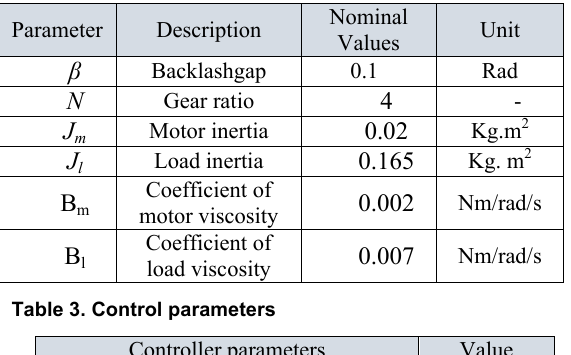
Table 2. Nominal parameters for the two-mass system with a gearbox[45] Parameter